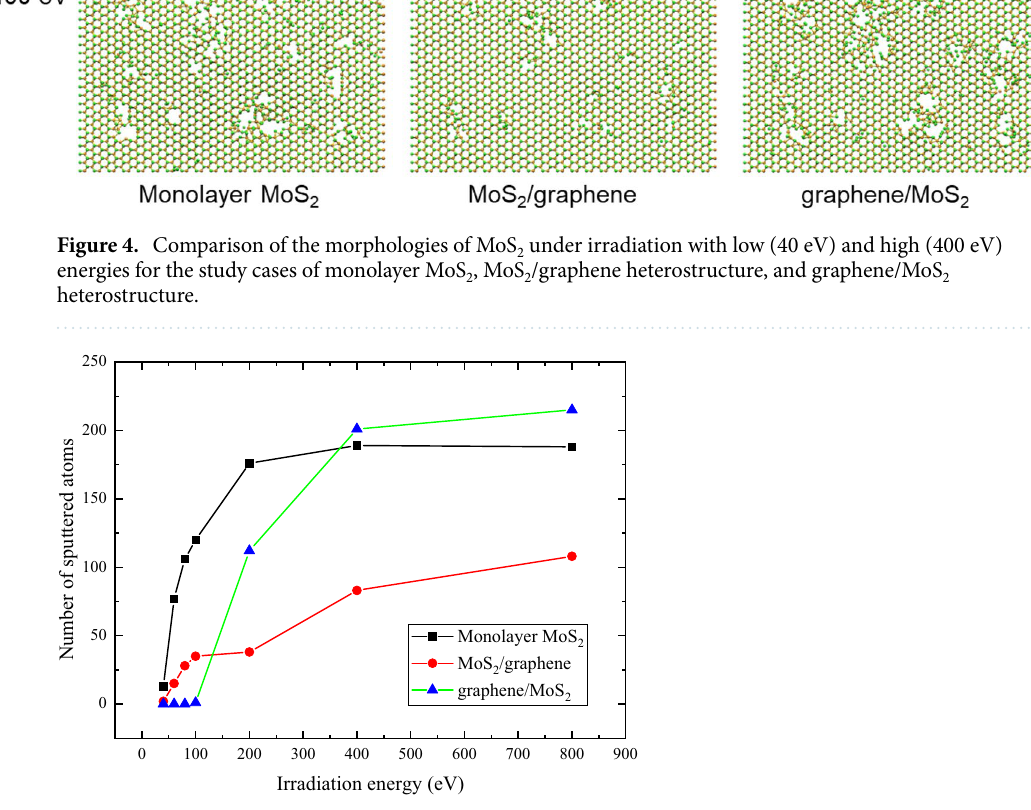
Figure 5. Dependence of the number of sputtered atoms in MoS 2 layer on irradiation energy for three study cases. The irradiation dose is 6.6 × 10 13 /cm 2